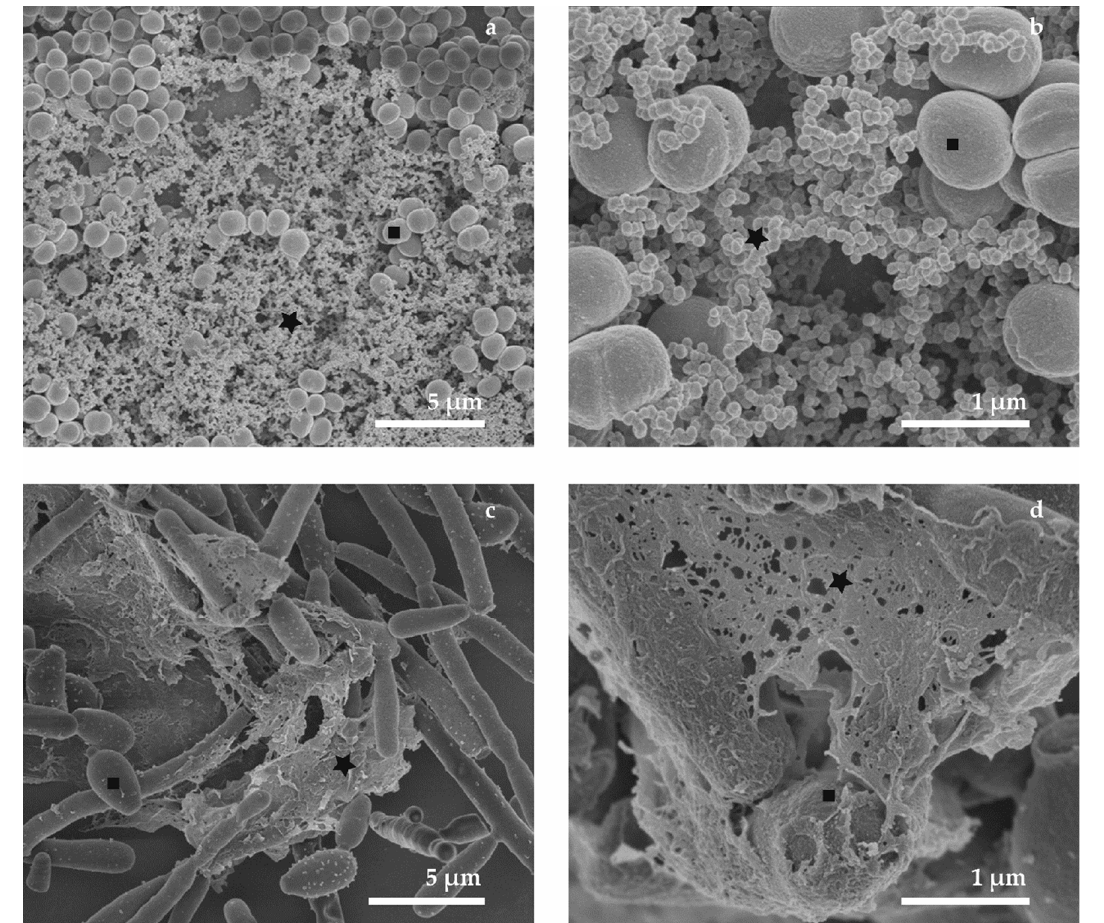
Figure 4. SEM micrographs show the comparison of the bacterial and yeast biofilm structure after the combined sample preparation: ( a , b ) S. epidermidis ; ( c , d ) C. parapsilosis . In the left column, images are displayed in a lower magnification, while the details are shown in the right column; measurement parameters: 2 keV, WD 6 mm.